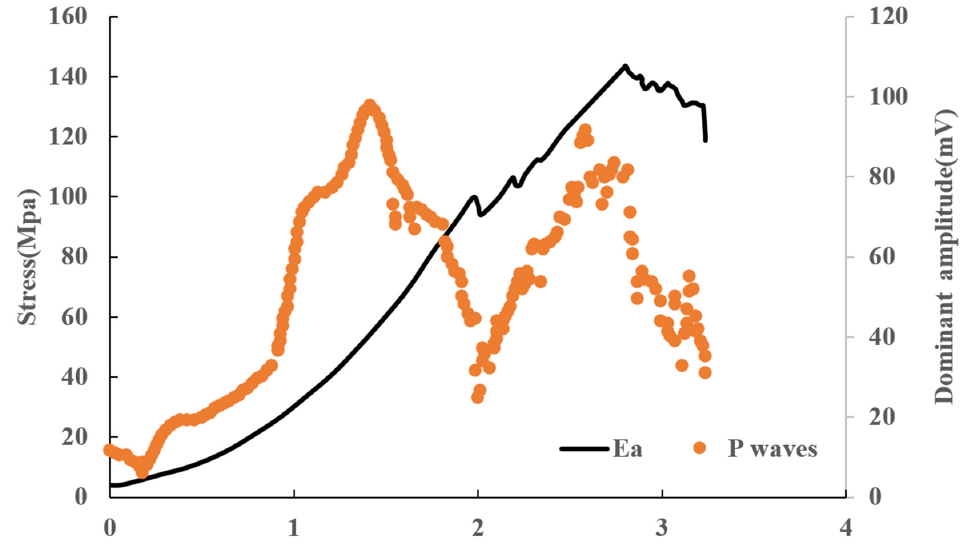
Figure 12. Stress–strain-dominant amplitude of the square shale sample (z-90-3).